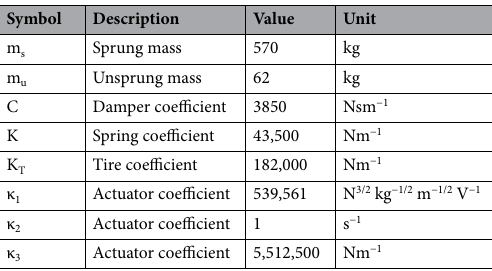
Table 1. Vehicle specification.